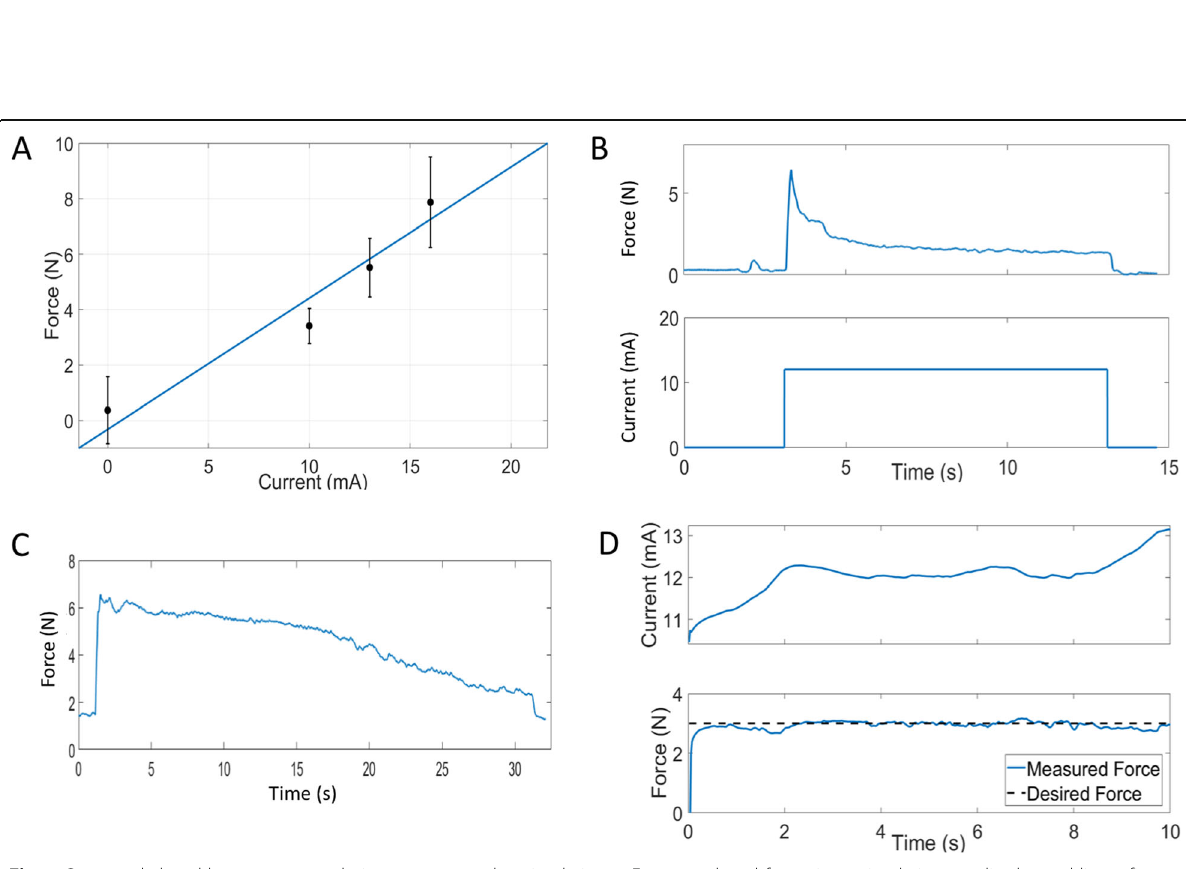
Fig. 4 Open and closed-loop responses during neuromuscular stimulation. a Force produced for various stimulation amplitudes and linear fit (blue). b and c Example open-loop responses to neuromuscular electrical stimulation. d Representative closed-loop response to a desired force step input; between 8 and 10s the controller automatically increases the current delivered to the target muscle to compensate for muscle